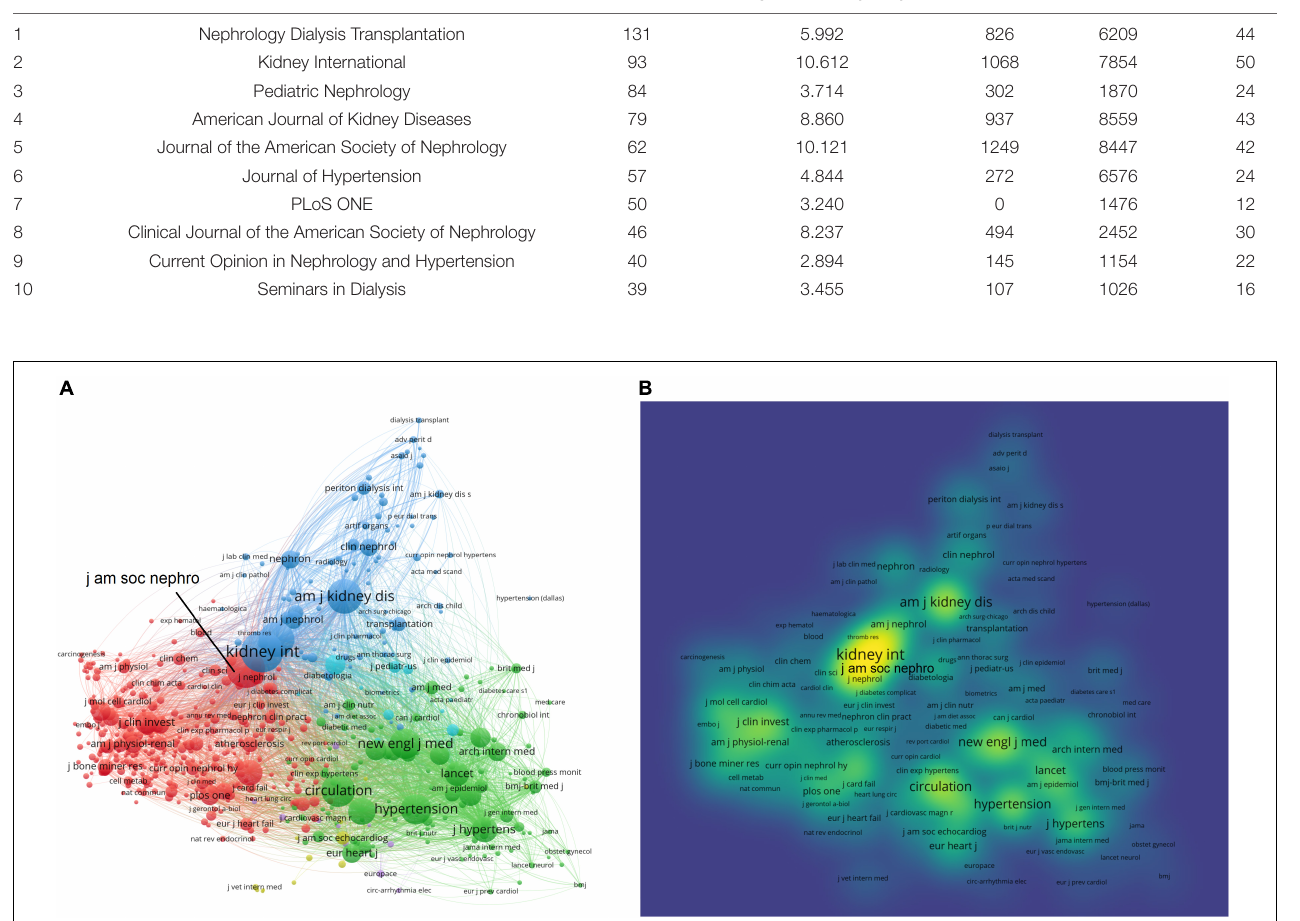
FIGURE 4 | Core journals in the uremic cardiomyopathy field. (A) Clustering of co-citation among journals. (B) Density visualization of journals based on the mean frequency of appearance, and journals in nephrology possessed a core position in clustering.